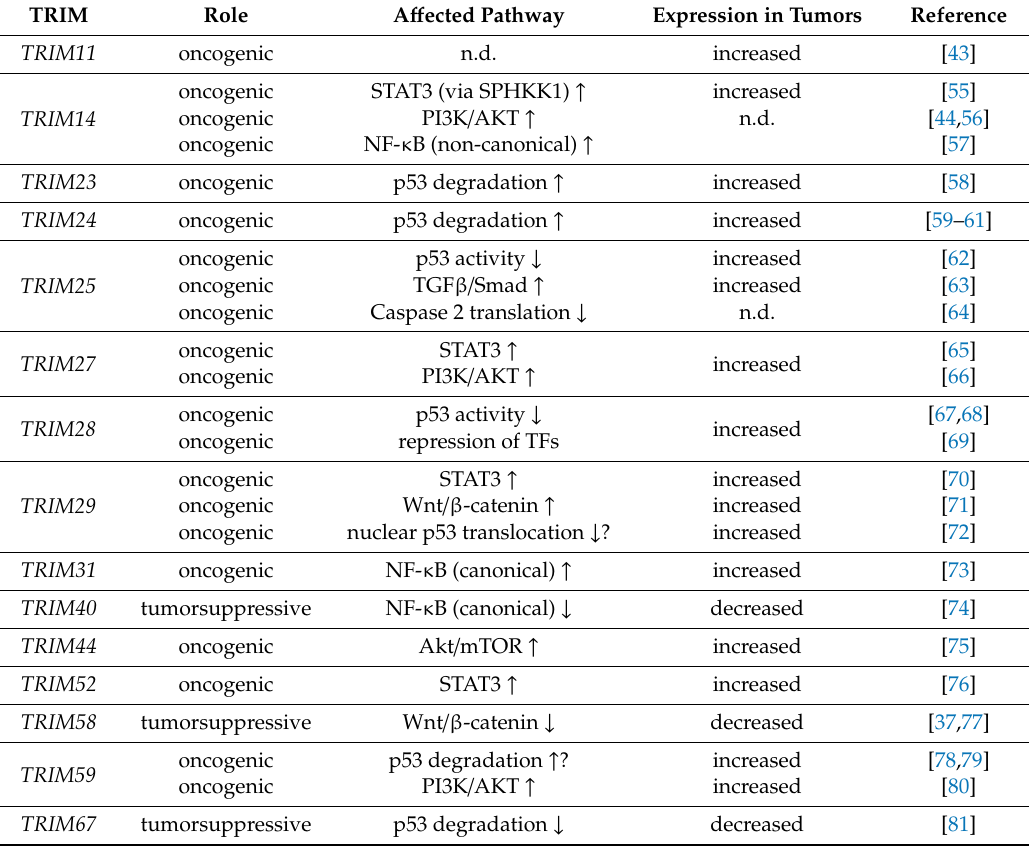
Table 1. Summary of TRIM family members with ascertained roles in the development and progression of tumors of the gastro intestinal tract (GIT) and their modulatory e ff ects on oncogenic signaling pathways ( ↑ : activation; ↓ : inhibition). In addition, the table depicts the aberrant expression levels of respective TRIM members in CRC tissue in comparison with normal tissue. n.d.: not determined; TF: transcription